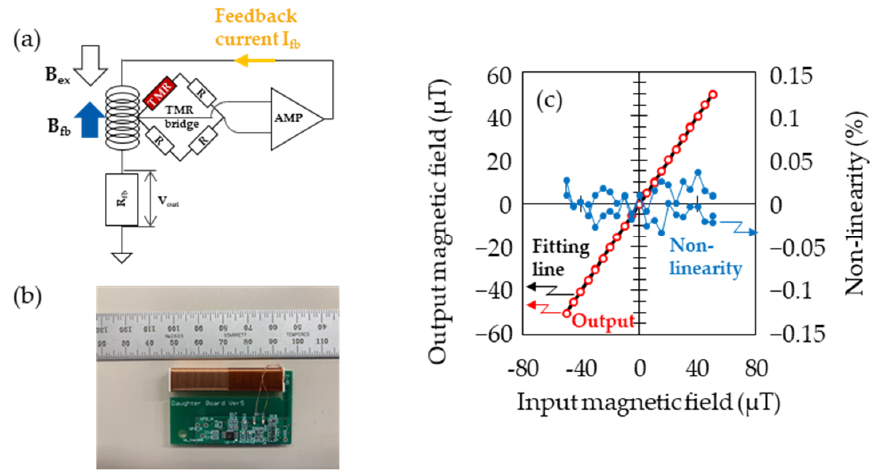
Figure 2. ( a ) Diagram of measurement using the closed-loop system. The amplified differential output from the bridge circuit with a TMR sensor used as a resistive element was induced to the feedback coil. ( b ) Photograph of TMR sensor covered by feedback coil. ( c ) Sensor output and non-linearity in the range of +/−50 μT. Non-linearity was calculated from V out after AD conversion, which was settled within the error of +/−0.1%.